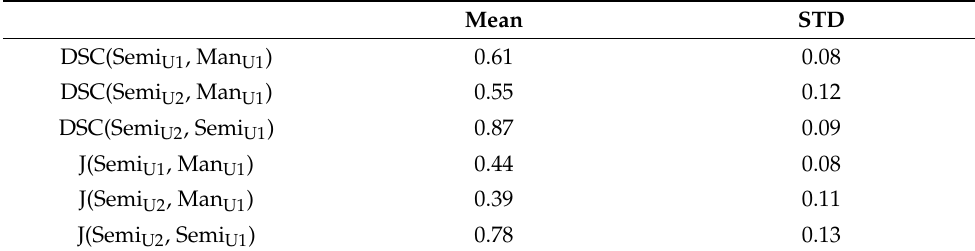
Table 1. Dice similarity coefficients (DSC) and Jaccard indices (J) between the semi-automatic segmentation Semi U1 and Semi U2 and the manual reference segmentation Man U1 . Further, the comparison between the two users U1 and U2 using the semi-automated method is shown. The latter is denoted as DSC(Semi U1 , Semi U2 ) or J(Semi U1 , Semi U2 ), respectively. Mean STD DSC(Semi U1 , Man U1